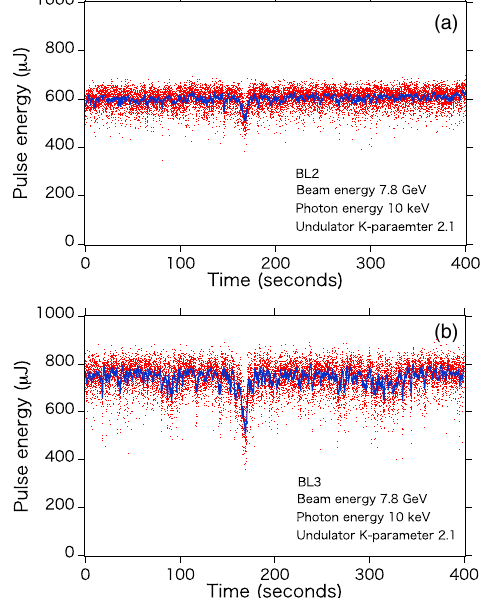
FIG. 8. XFEL pulse energies obtained in the multi-beam-line operation, (a) BL2 and (b) BL3. The photon energy is 10 keV. The red dots represent single-shot results and the blue lines show averaged values over one second. The electron beam energy is 7.8 GeV and the repetition of the electron beam is 60 Hz.